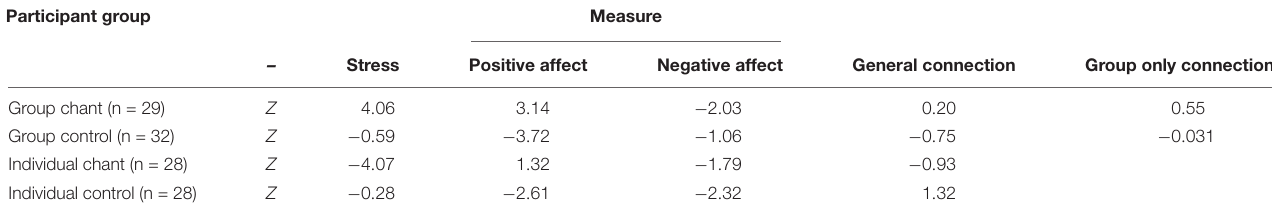
TABLE 1 | Standardized change scores across conditions (measured at pre-intervention to post-intervention;